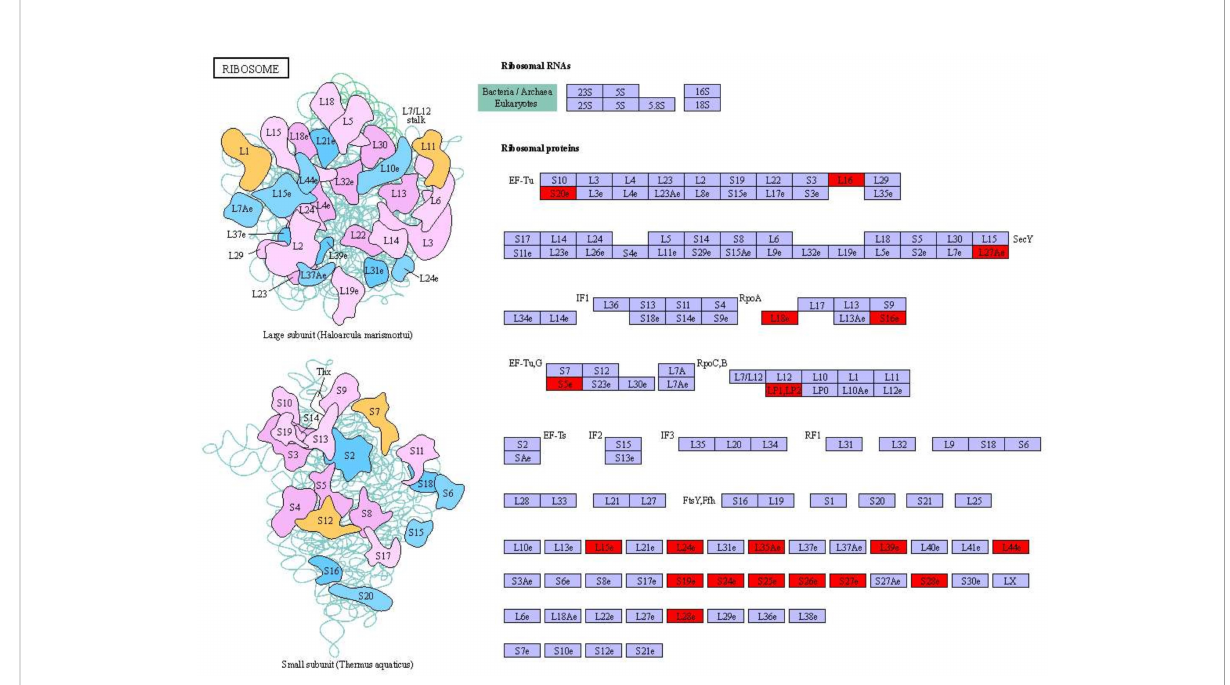
FIGURE 5 Signi fi cantly differentially expressed genes of ribosome-related pathways in D2 dsGFP vs. D0 dsGFP of S. paramamosain . Red indicates signi fi cantly upregulated genes. (For interpretation of the short letters ’ meaning in this fi gure legend, the reader is referred to the web version of KEGG: ko03010.).